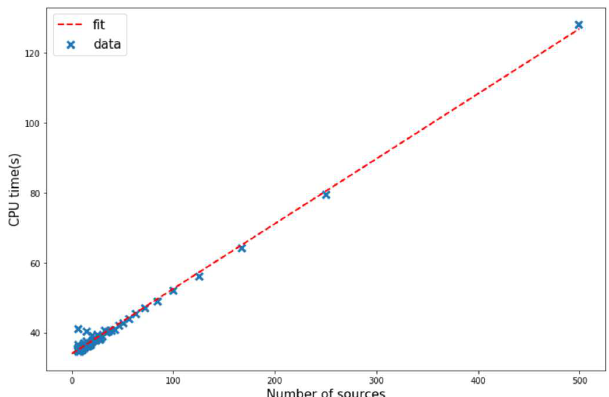
Fig. 17. CPU time for Dijkstra’s algorithm vs the number of sources and targets for the experimental map at the macroscopic strain (cid:15) = 12% - 500 × 500 image i.e. 251 001 (= 501 × 501 ) nodes in the corresponding graph (with the parametrization assumed in this